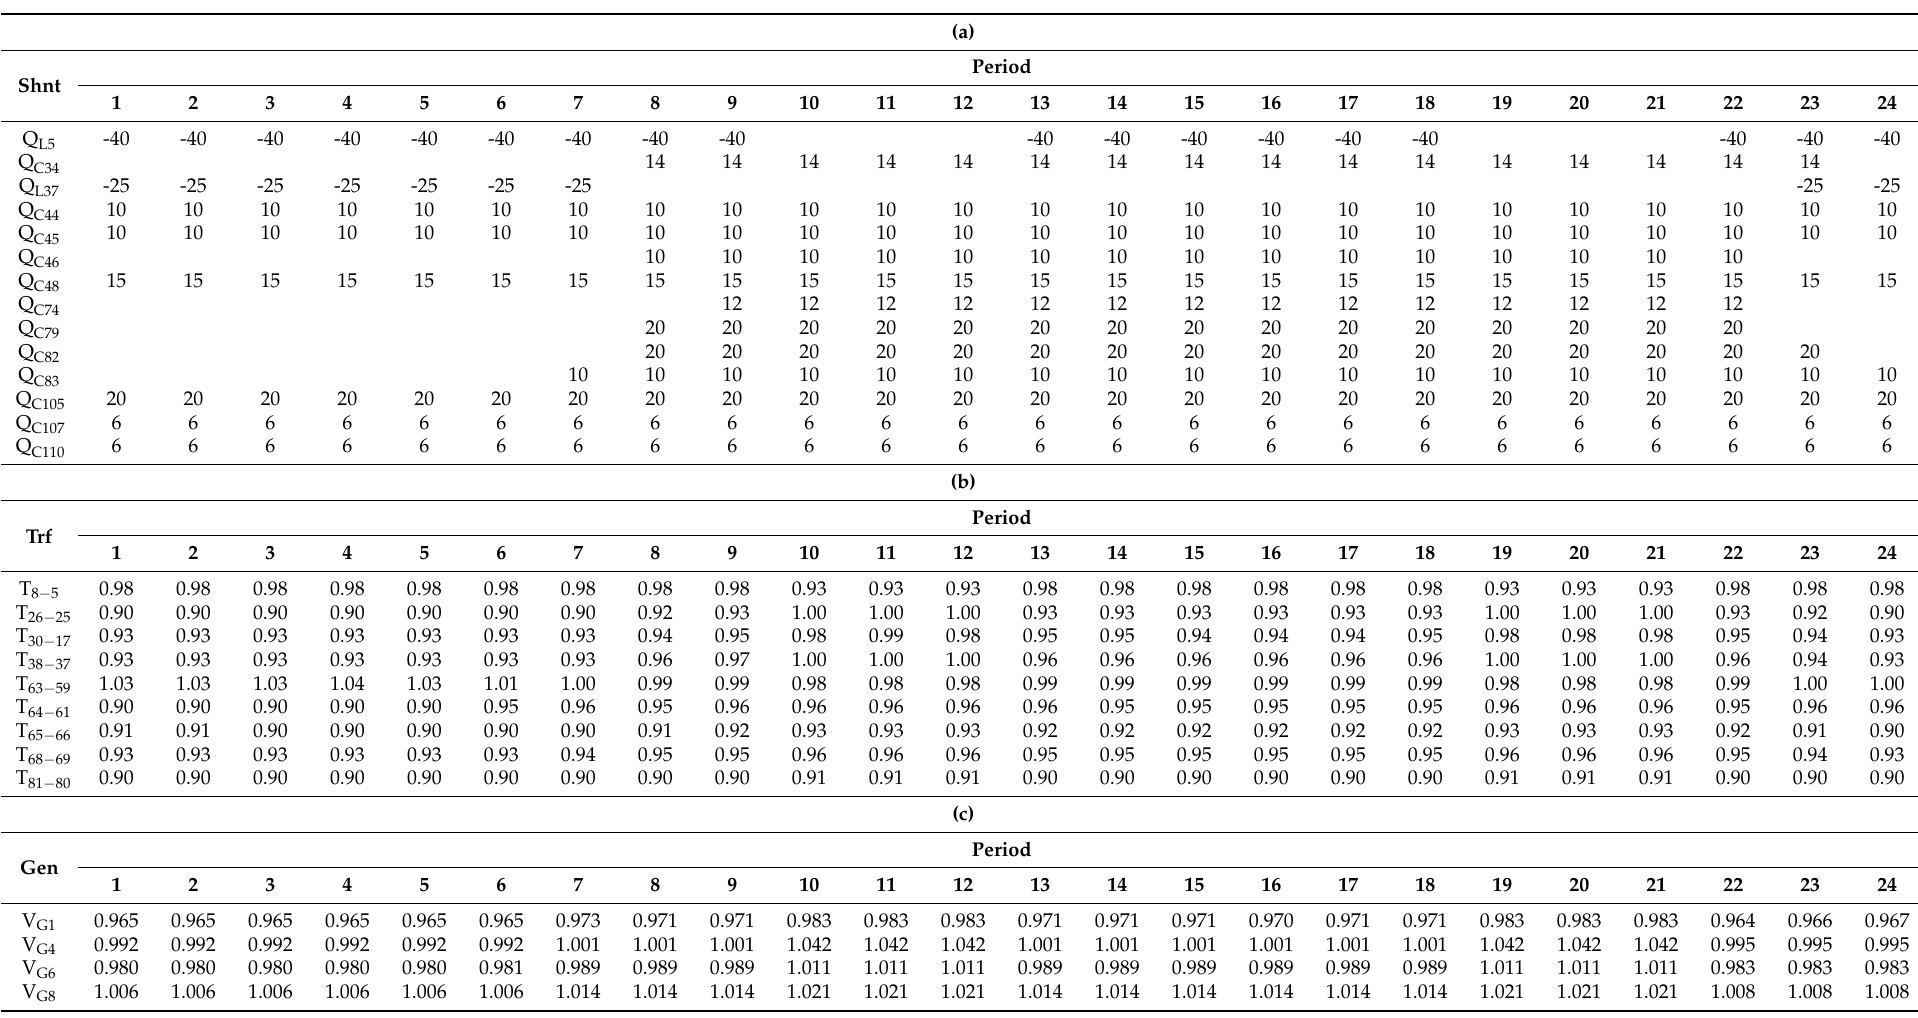
Table A2. Schedule of control variables of the MP-ORPD for the IEEE 118-bus